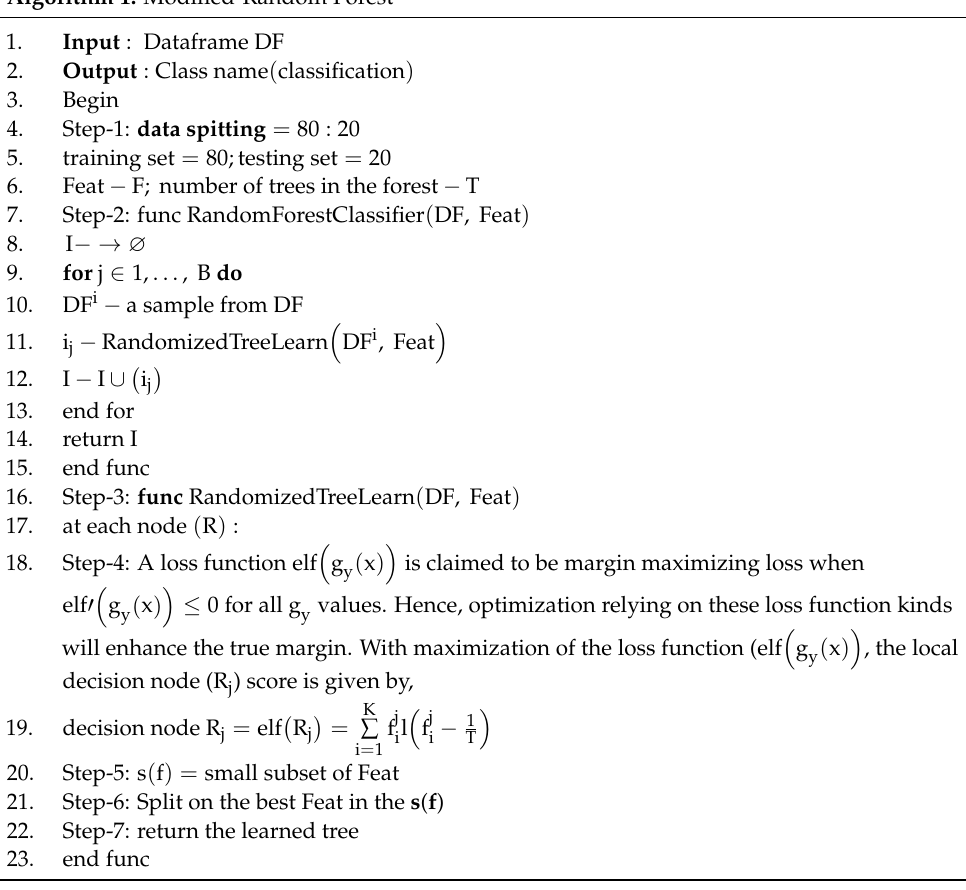
Algorithm 1: Modified-Random